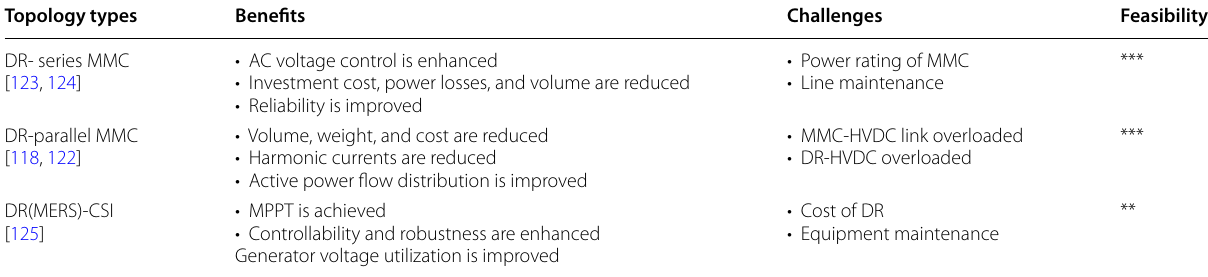
Table 6 Topology of DR-HVDC for OWFs Topology types